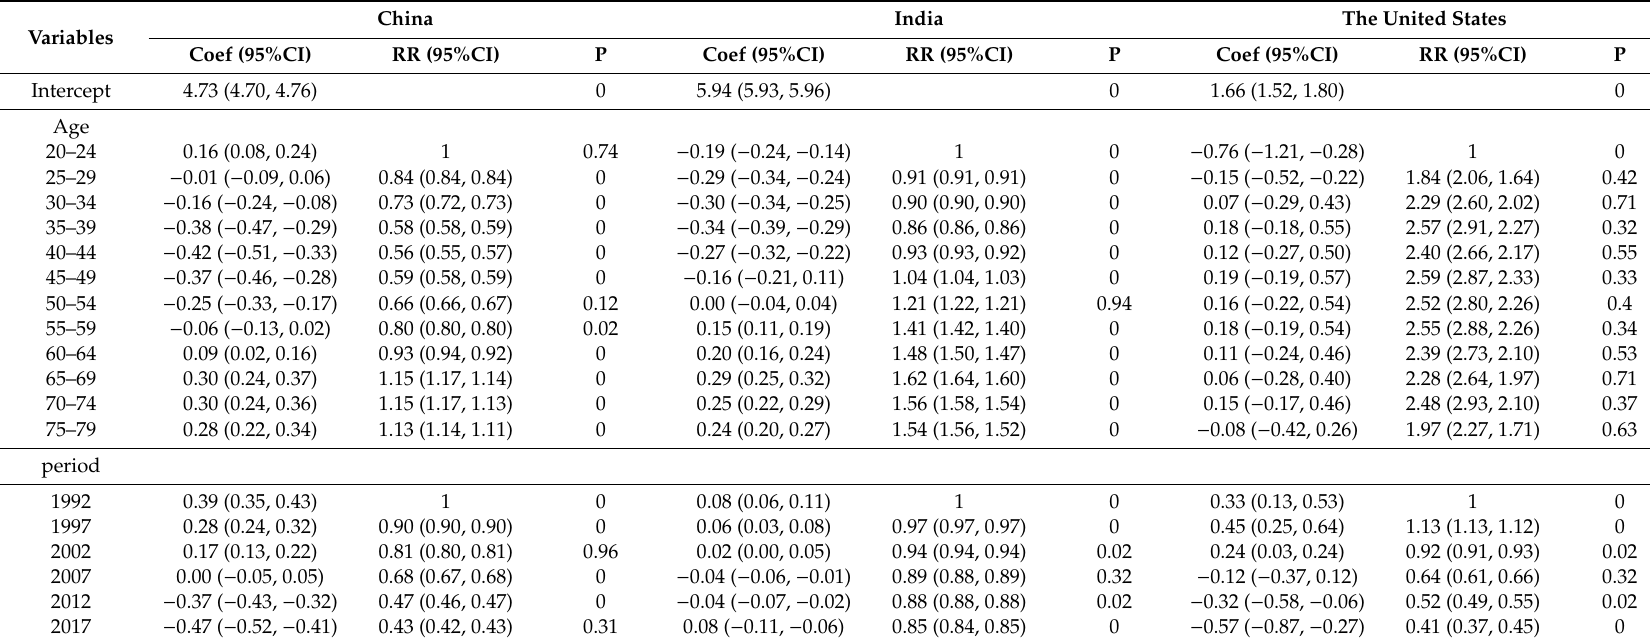
Table A1. APC model analysis results of TB incidence in China, India, and the United States,